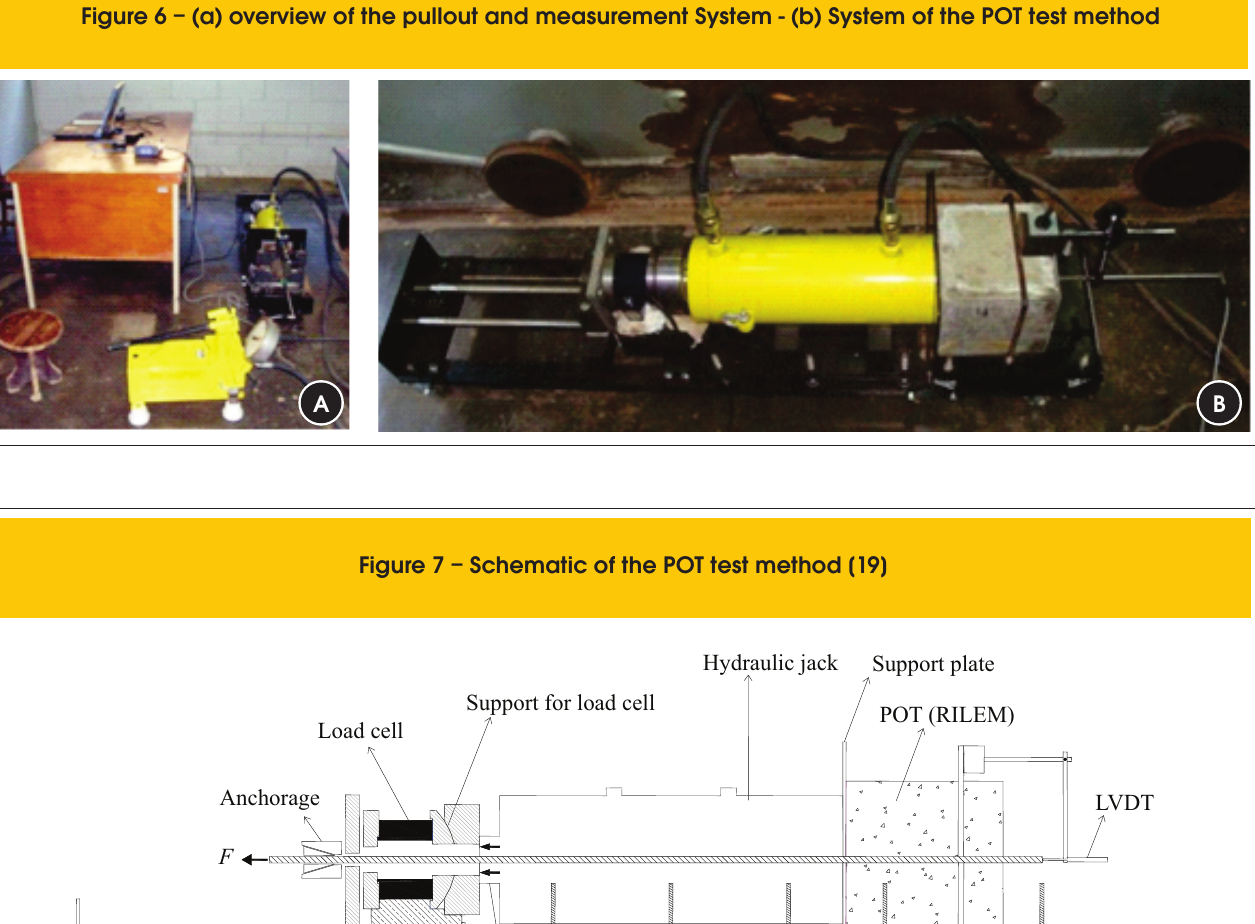
Figure 6 – (a) overview of the pullout and measurement System - (b) System of the POT test method